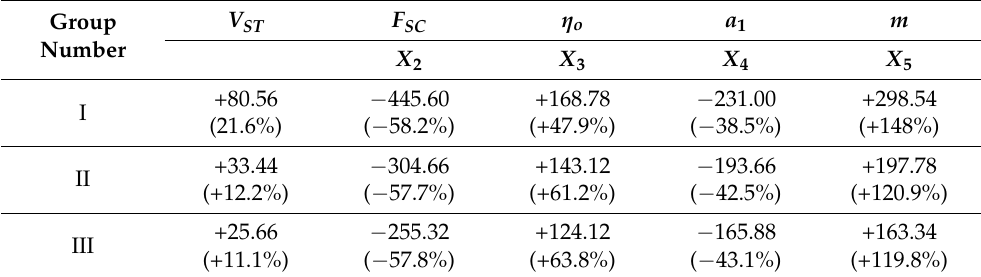
Table 6. Effects of changing X 1 ÷ X 5 factors from lower to higher level on annual useful energy output [kWh/m 2